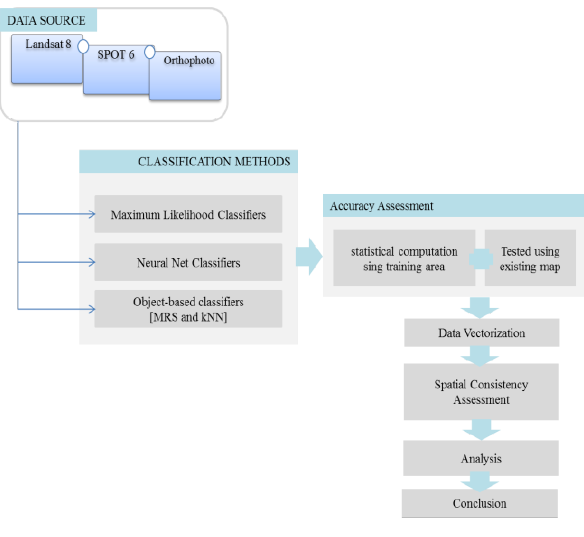
Figure 3. Research methodology